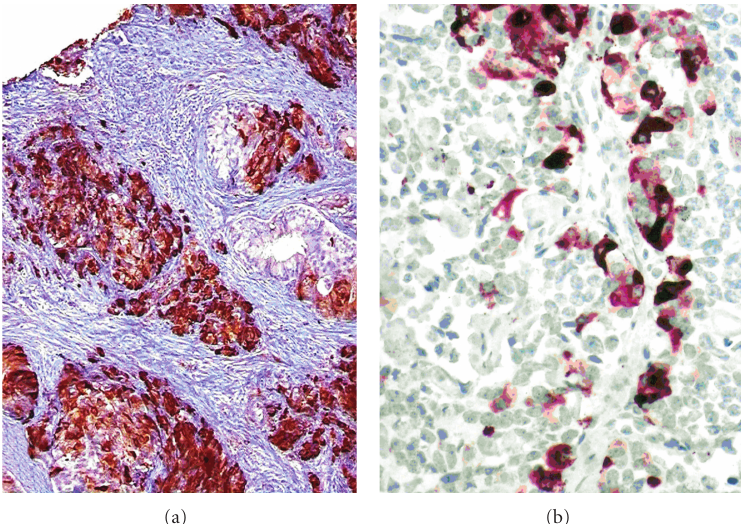
Figure 4: Conventional PCa (Gleason 4 + 4 = 8) detected in a needle biopsy. Chromogranin A (CGA) immunohistochemistry reveals extensive neuroendocrine (NE) di ff erentiation, which presents a multidrug-resistant phenotype in PCa (a). Immunohistochemical detection of somatostatin receptors in NE PCa cells (b) provides a therapeutic target for somatostatin analogues. Original magnifications: (a) ( × 100), (b) ( ×